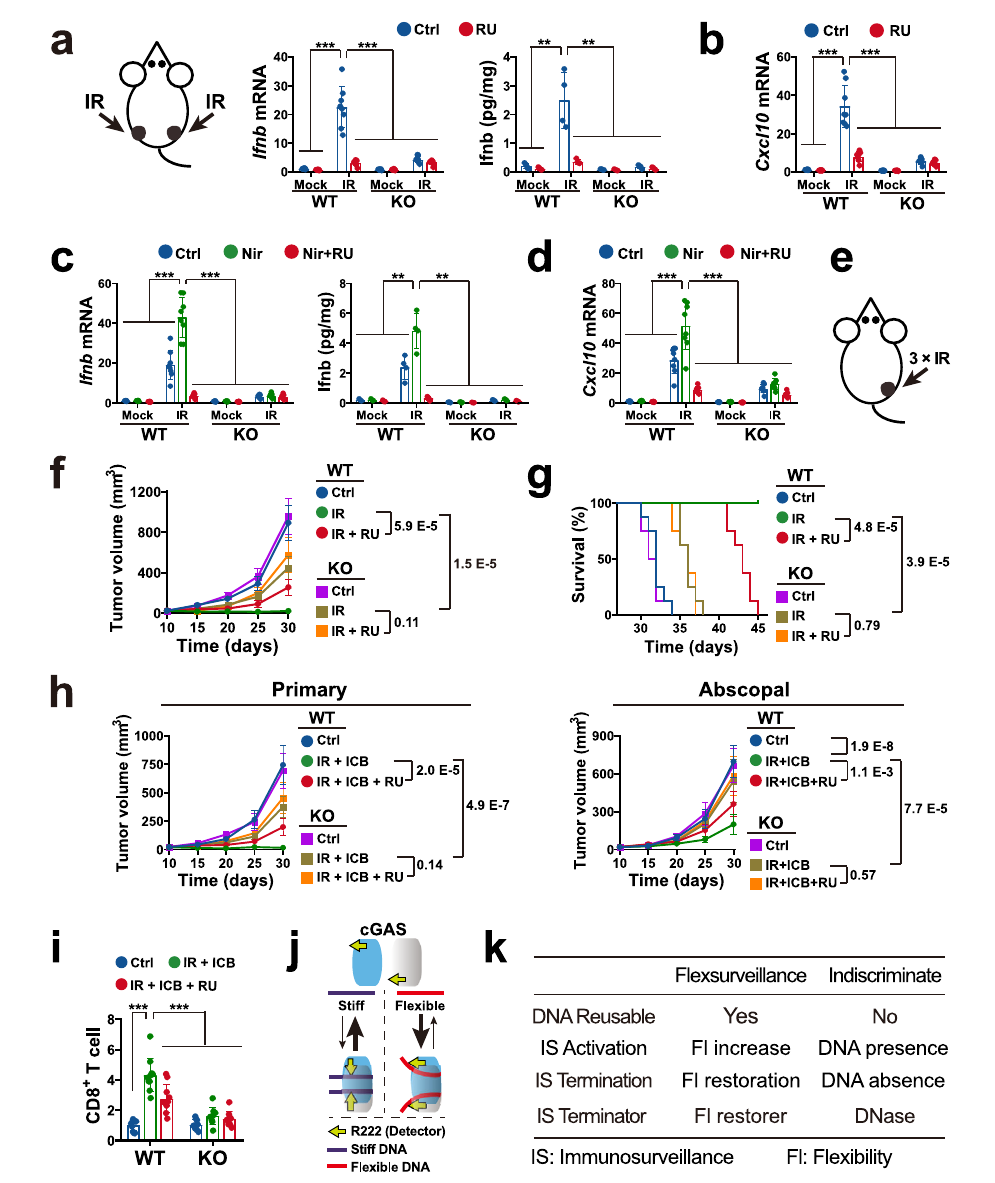
Fig. 10 | Loss of cGAS-mediated daily AIS impairs the radiotherapy ef fi ciency. a Ifnb mRNA (left) and protein (right) levelsin the tumoursat 4h after single focal 8Gy IR.Mean±SD. MRNA: n =8tumoursfrom 4 mice.Protein: n =4tumoursfrom 4mice. b Cxcl10mRNAlevelsinthetumoursin ( a ).Mean±SD. n =8tumoursfrom 4mice. c IfnbmRNA(left)andprotein(right)levelsintheinhibitor-pretreatedmice at 4h after single IR. Before IR, mice were injected with 5mg/kg RU.521 for 3h or treated by oral gavage with 4mg/kg of niraparib for 3h. Mean±SD. MRNA: n =8 tumoursfrom 4mice. Protein: n =4tumoursfrom 4mice. d Cxcl10mRNA levelsin the tumours in ( c ). Mean±SD. n =4 tumours from 4 mice. e Schematic showing right fl ankimplantedtumourtreatedbythreefocalfractionsof8GyIRonD10,D11 and D12. f , g Tumour volumes ( f ) and survival percentages ( g ) in the RU.521-pre- treated mice described in ( e ). P values in ( f ) were from unpaired two-sided